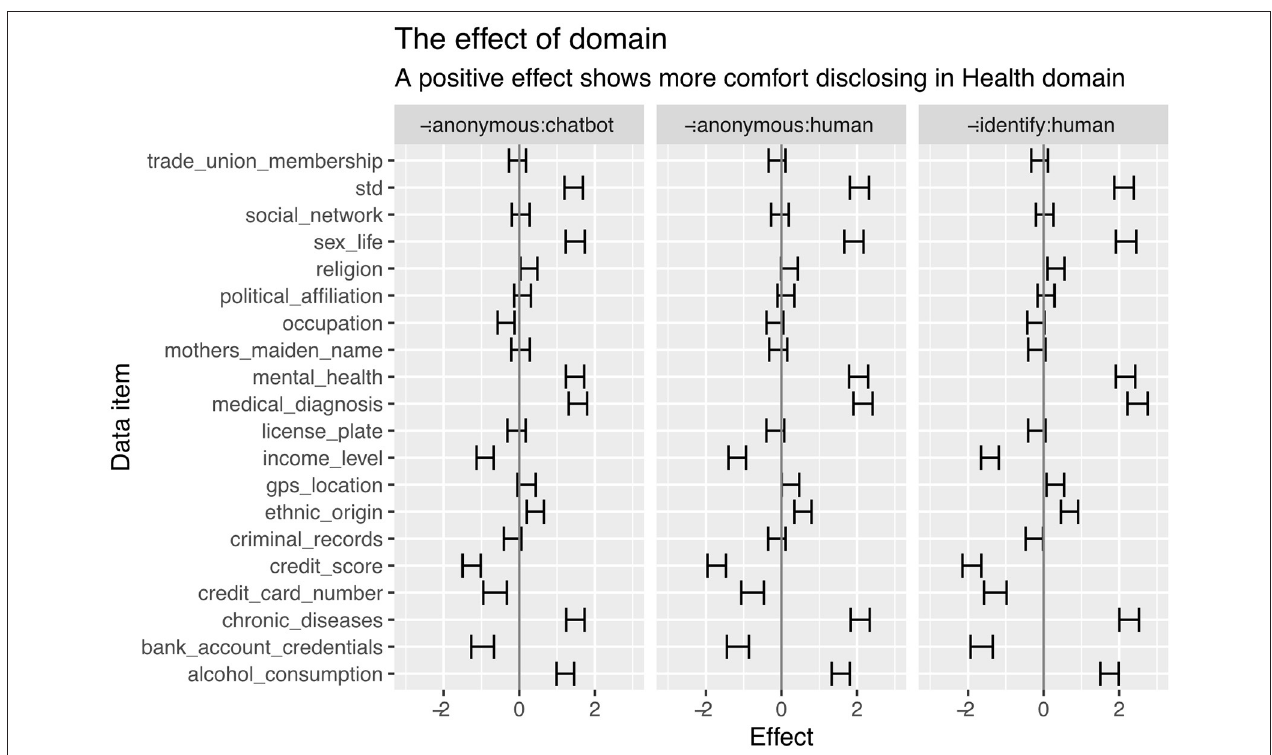
FIGURE 6 | The influence of context across different scenarios of information